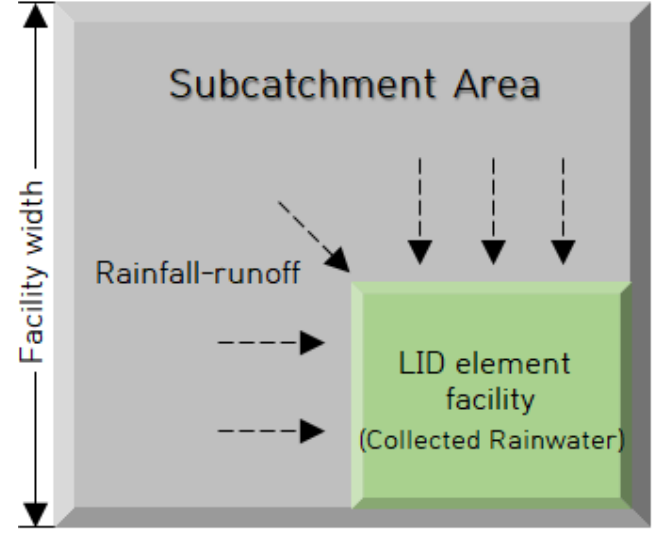
Figure 2. Concept of LID construction based on catchment area.